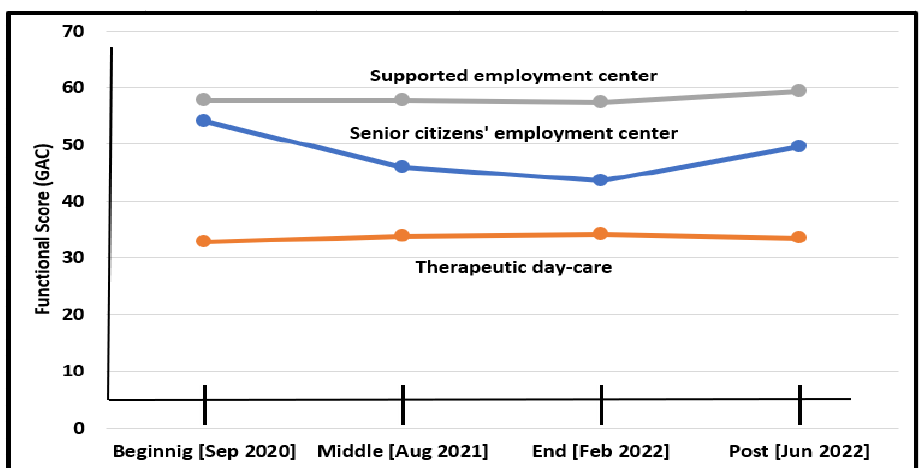
Figure 3. Functional changes for three groups of daycare (September 2020 – end of June 2022).